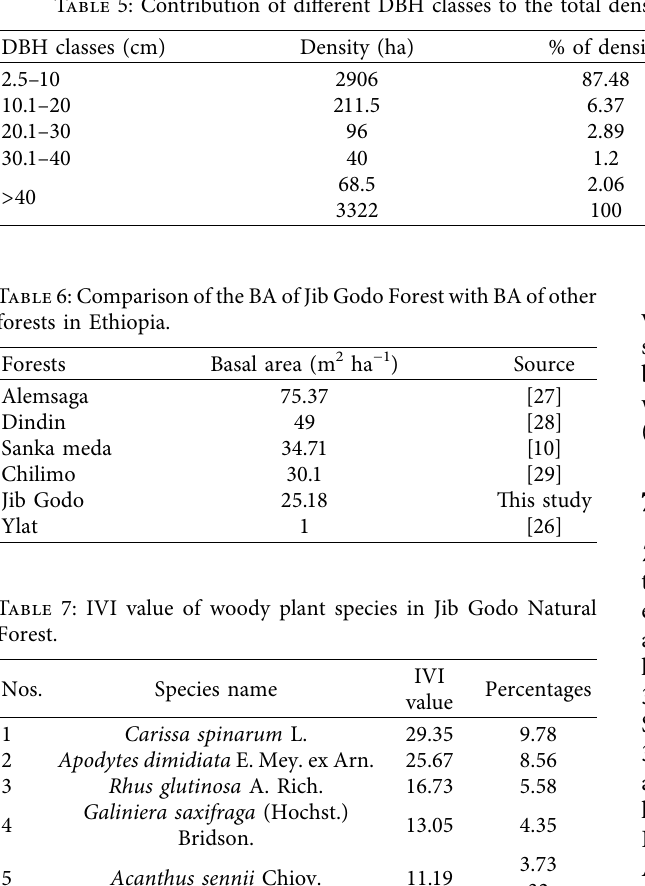
Inverted J shape (Figure 11(a)): Tis pattern has a large number of individuals at the seedling stage and a smaller number of individuals at the sapling and adult stages, with typical inverted J-shape curves. I form (Figure 11(b)): In this pattern, seedlings and